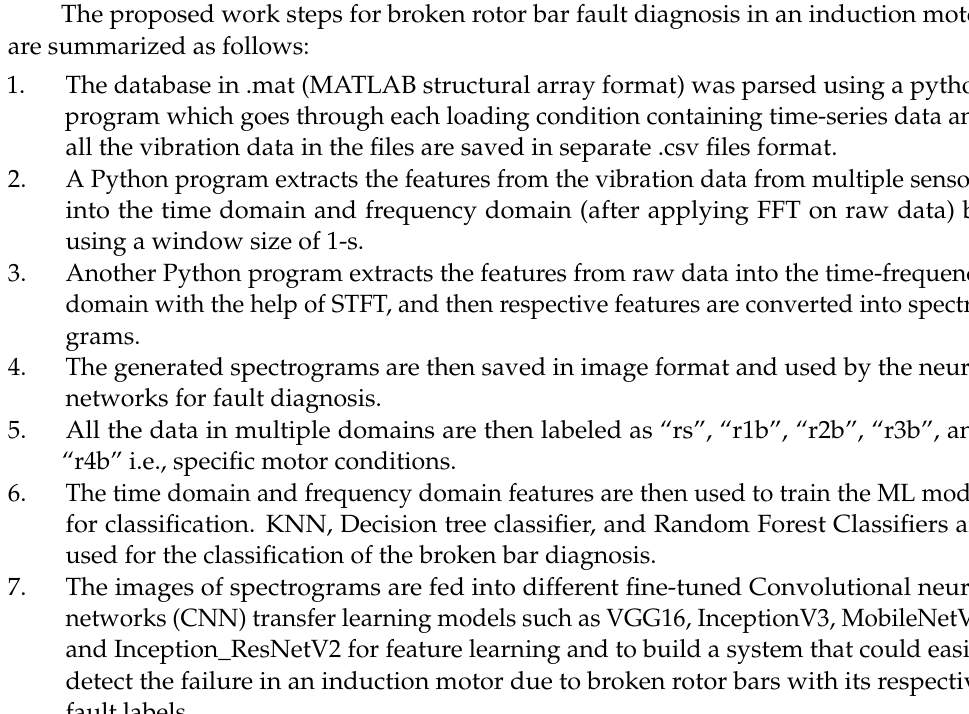
Figure 6. Fine-tuned Transfer Learning approach in pre-trained CNN models.